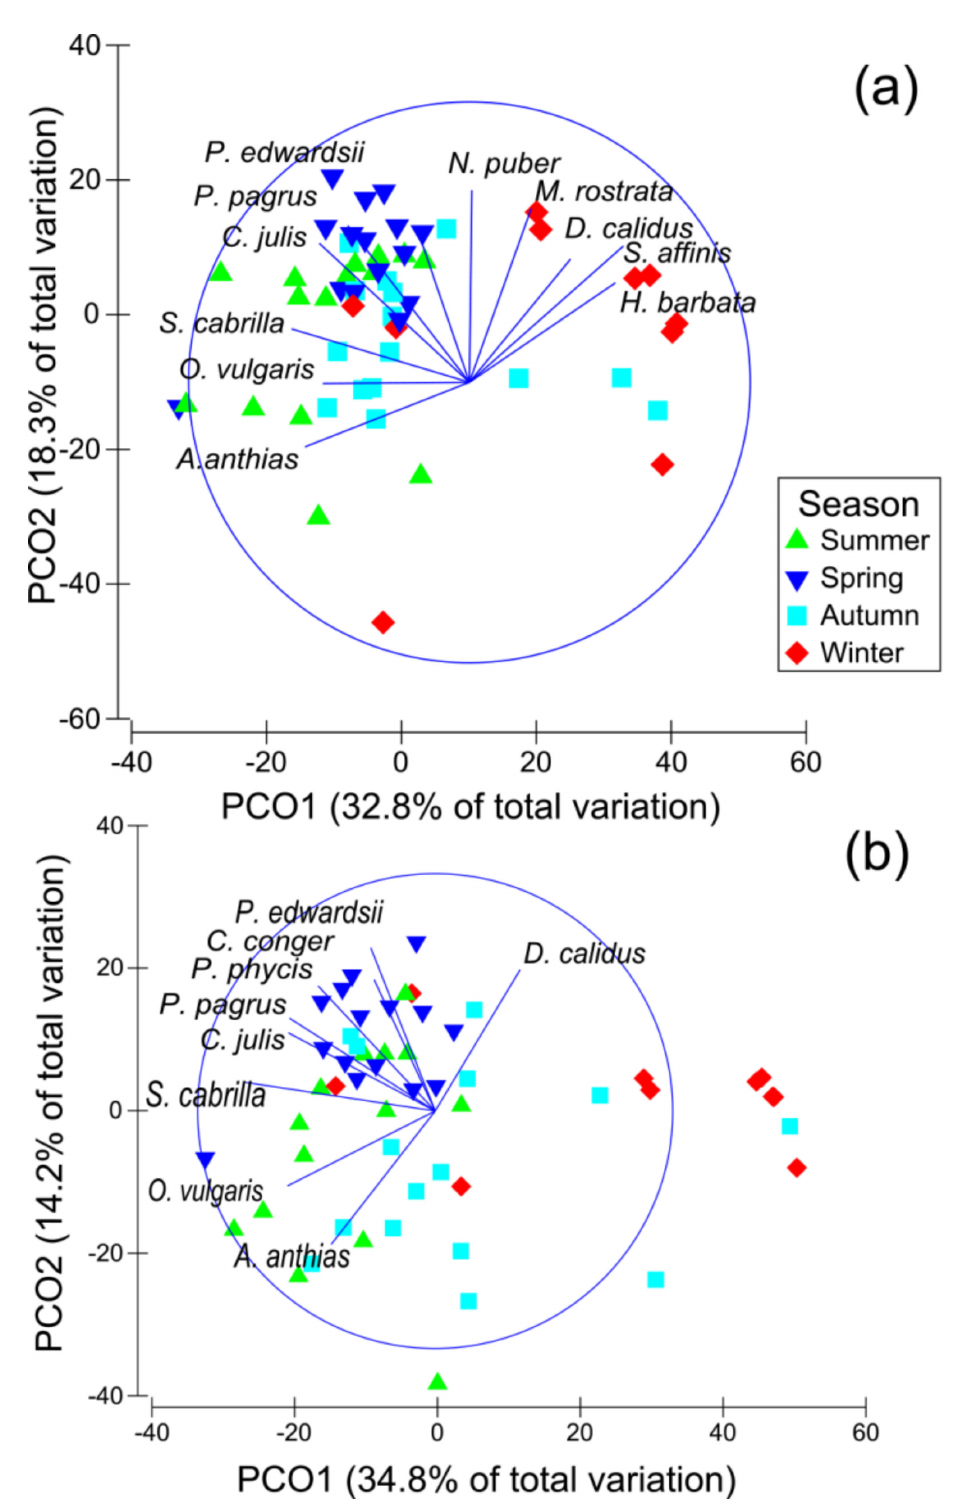
Figure 4. Seasonal principal coordinate analysis (PCoA) plot of bycatch species based on density ( a ) and biomass ( b ). Two axes explained 51.1% of the total variation in density and 49% for biomass. Species with a Spearman rank order correlation higher than 0.6 are shown as the overlying